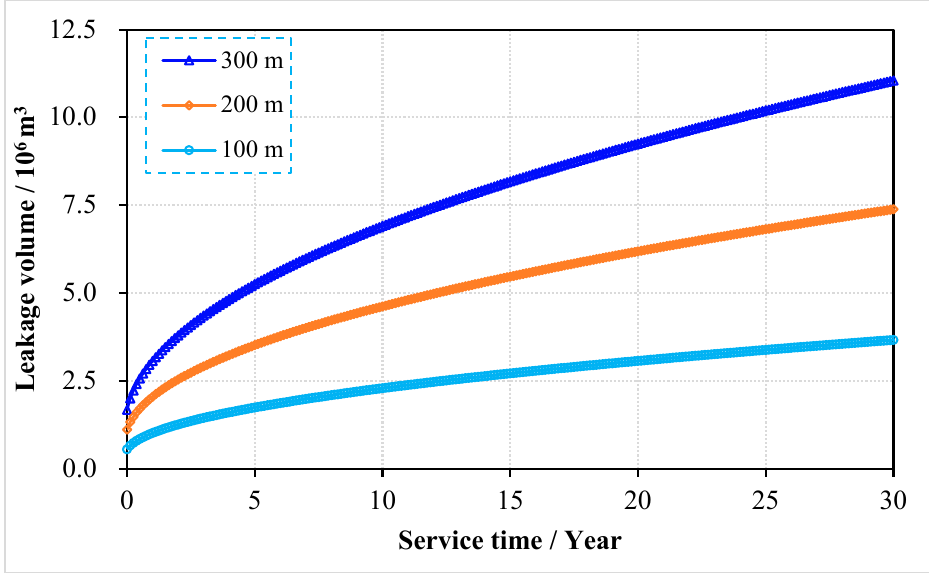
Figure 7. Accumulated leakage volume in coal pillars under different depths.